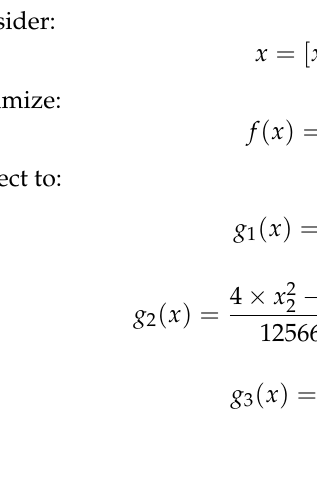
Figure 12. Schematic diagram of tension/compression spring design.